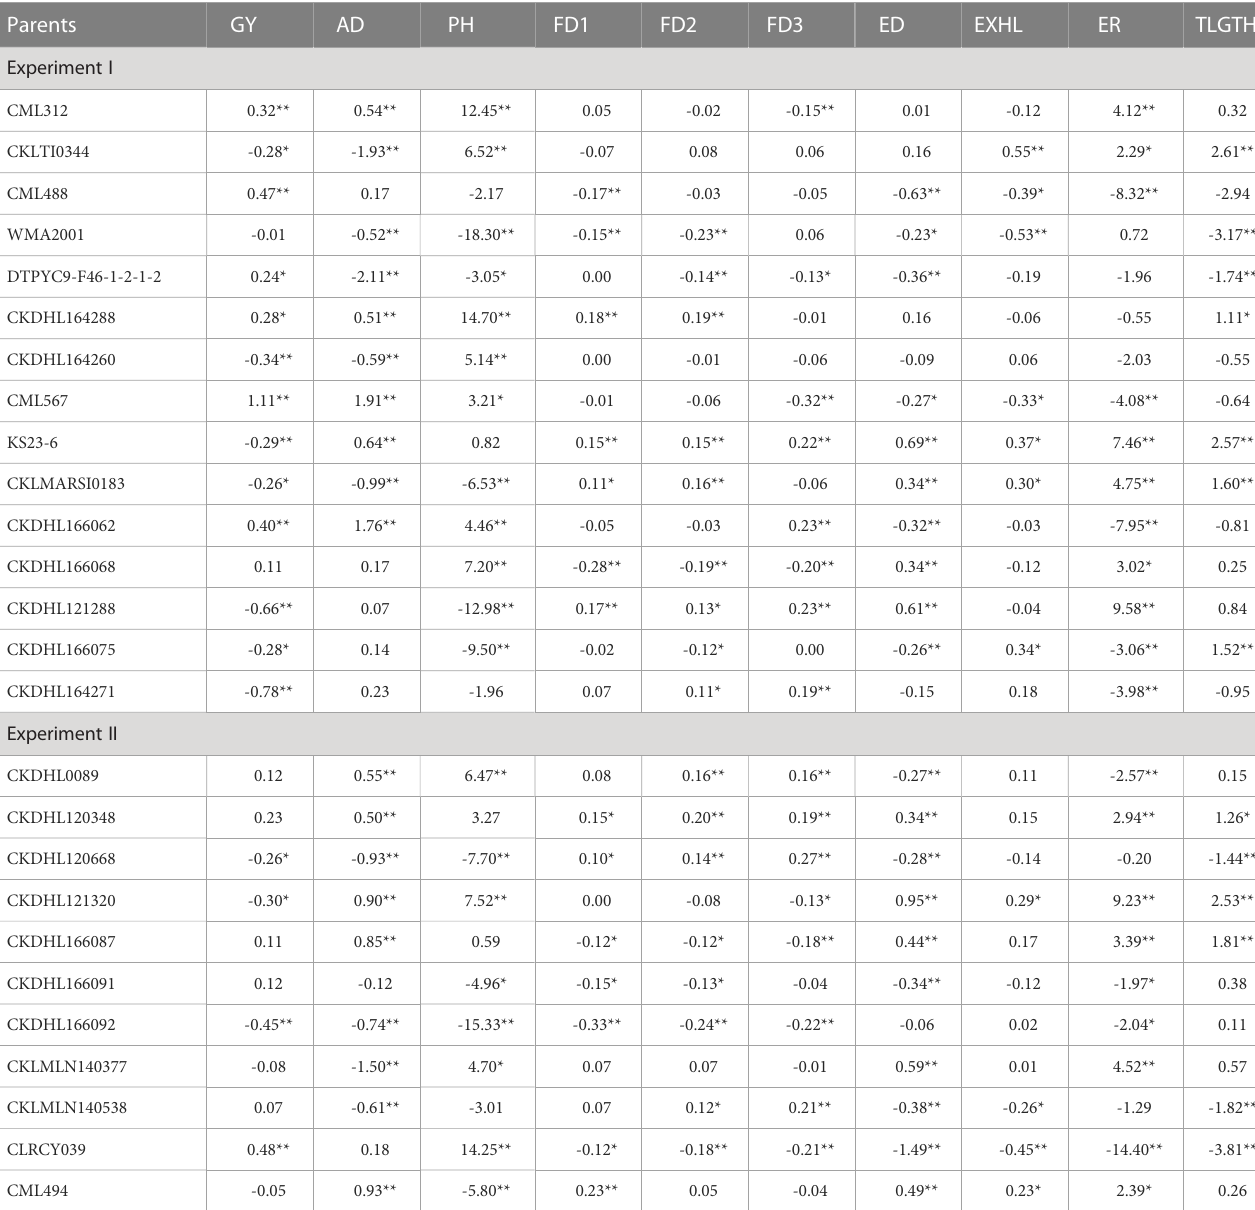
TABLE 6 General combining ability effects of the white maize inbred lines for grain yield and other traits under arti fi cial infestation of FAW